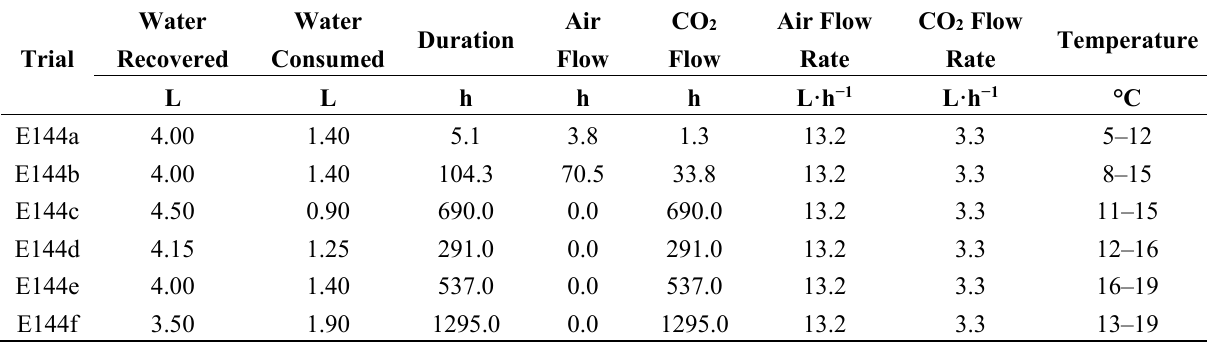
Table C12. ZVM TPA Example (Trial E144): Salinity changes calculated from changes in EC, spectrometry, and changes in water volume.